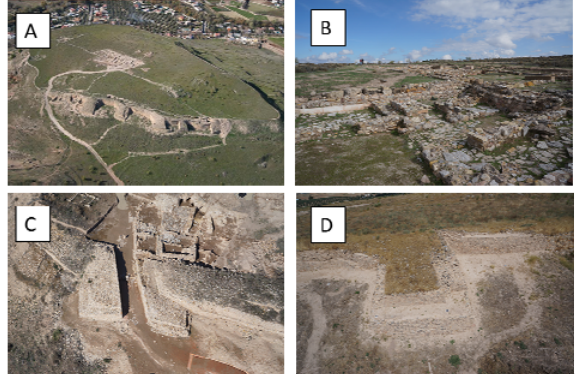
Figure 1. Iberian Puente Tablas Oppidum (Vth-IVth BC). A: